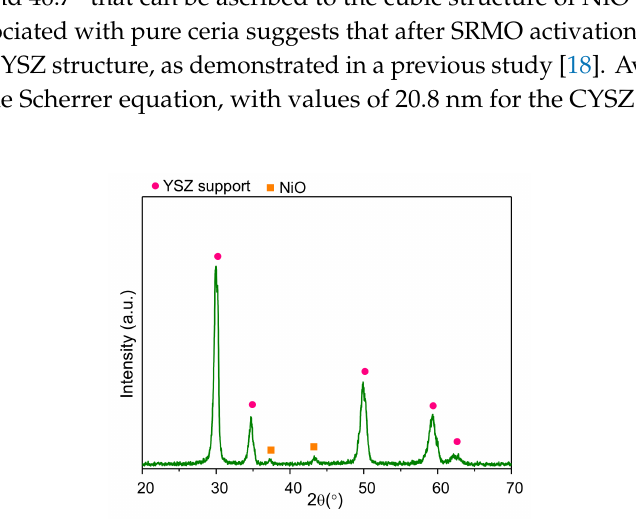
Figure 1. XRD pattern of the Ni-CYSZ material. ( (cid:8) ) Tetragonal corresponding to YSZ supports and ( (cid:4) )